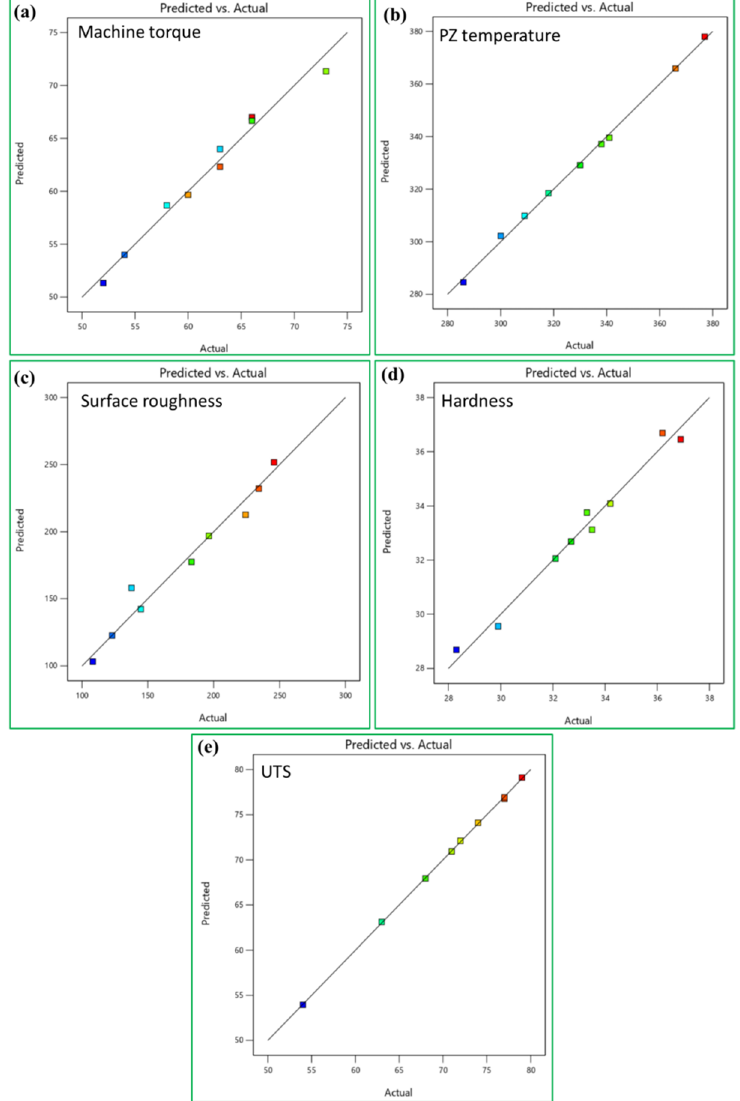
Figure 7. Correlation diagram between the actual and predicted values of the ( a ) recorded machine torque model, ( b ) PZ temperature, ( c ) surface roughness, ( d ) hardness, and ( e ) tensile strength.